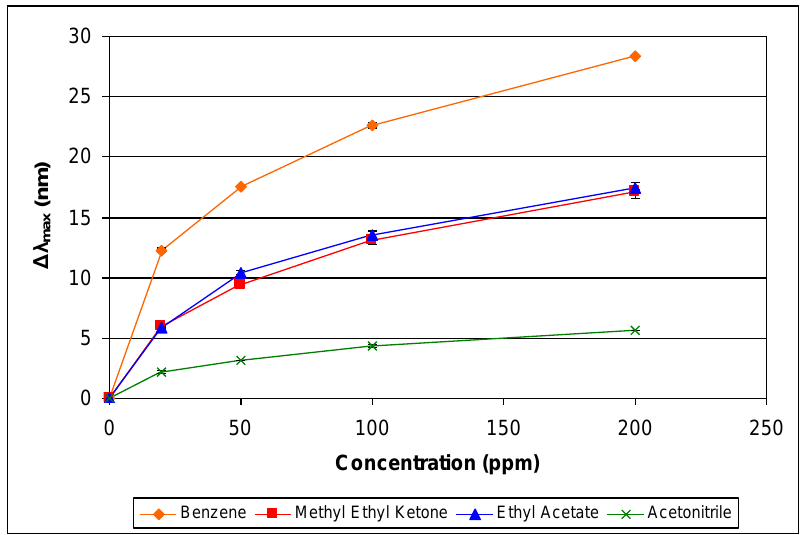
Figure 12. Comparative responses of sensor to organic vapors with similar vapor pressures and similar boiling points at various